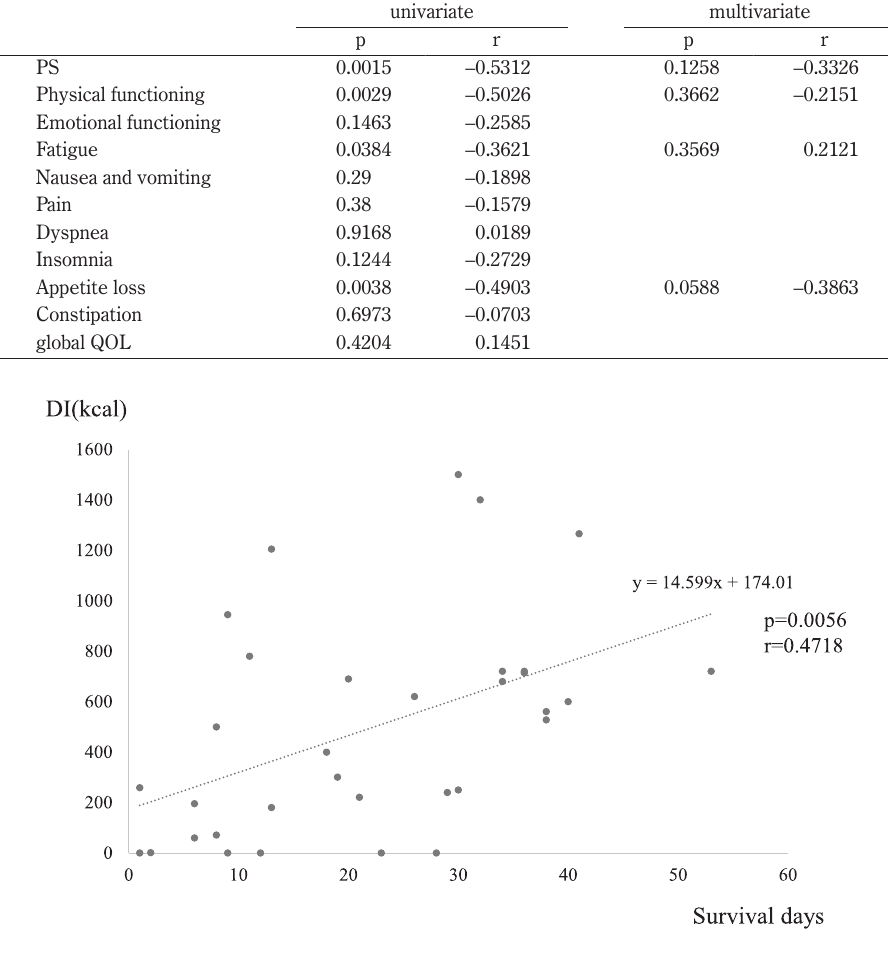
Figure 1 Correlation between DI and